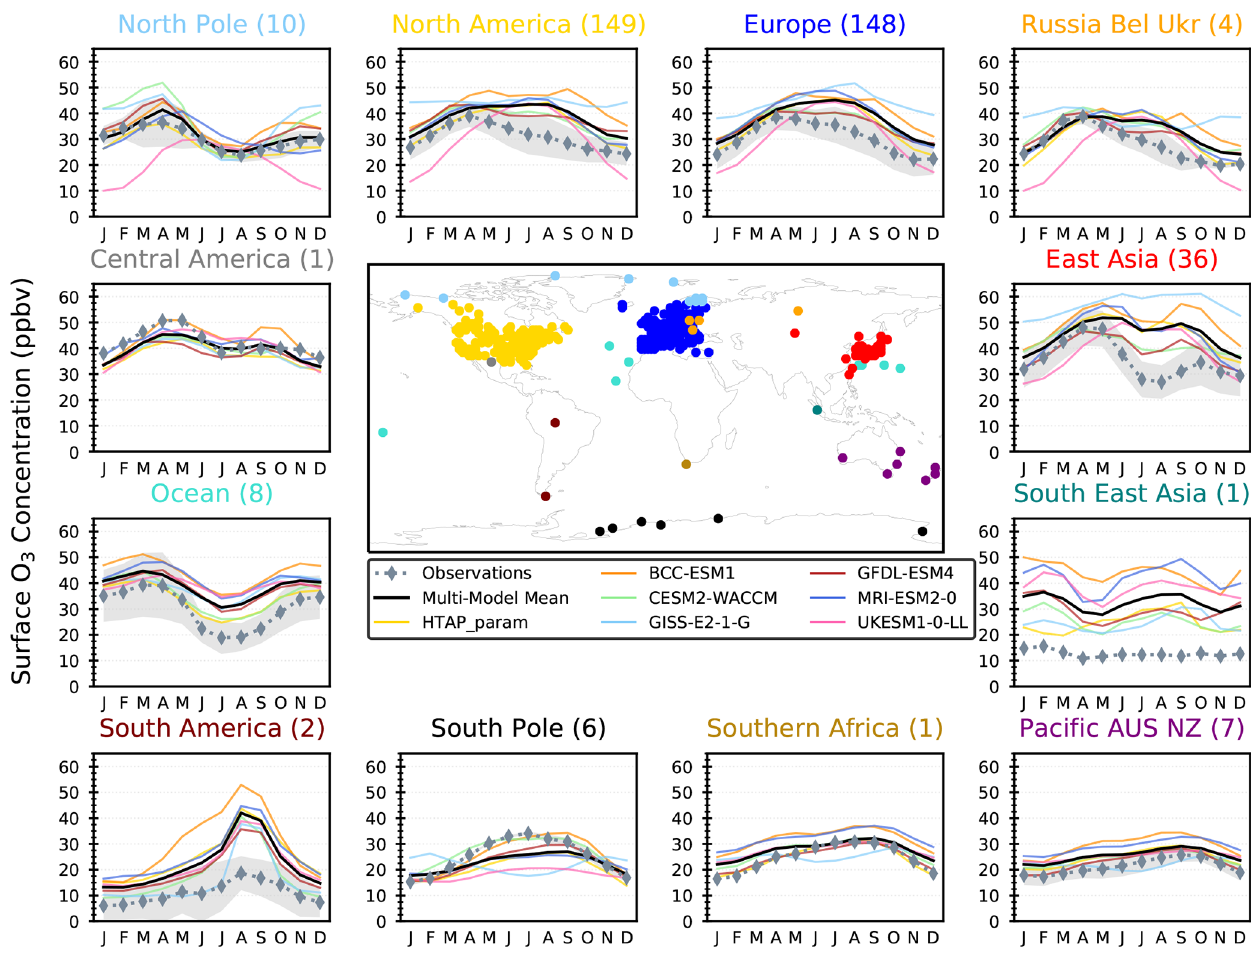
Figure 4. Individual and multi-model (six CMIP6 models and HTAP_param) monthly mean surface O 3 concentrations across different world regions compared with the regional monthly values from all the TOAR observations within the region for the period 2005–2014. The number of observations within a region is shown in parentheses. The shading shows variability in observations across all sites within the